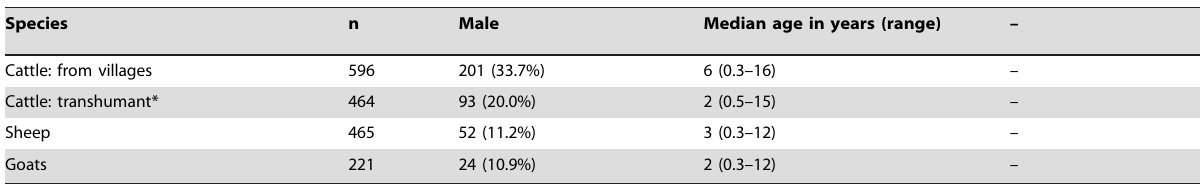
Cattle: from villages